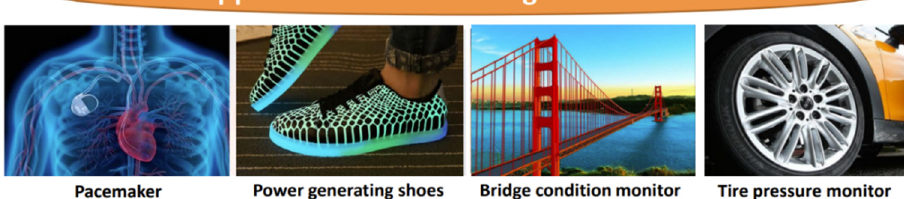
Figure 1. The target applications of micro energy harvesting.